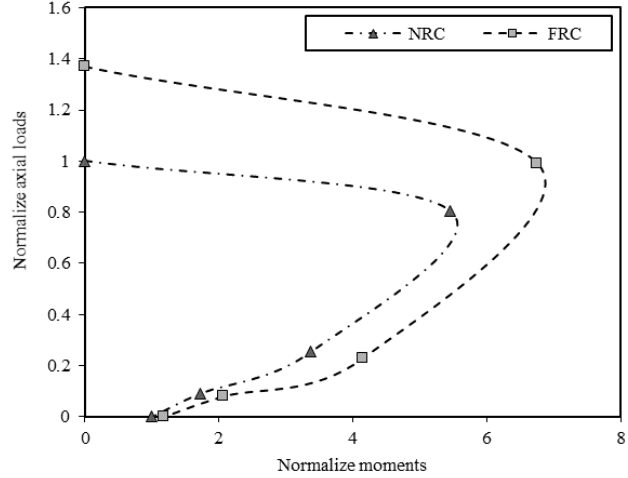
Figure 20. ( a ) Deflection at ultimate load for the NSC and FRC specimens; ( b ) relative displacement and horizontal displacement at ultimate load.